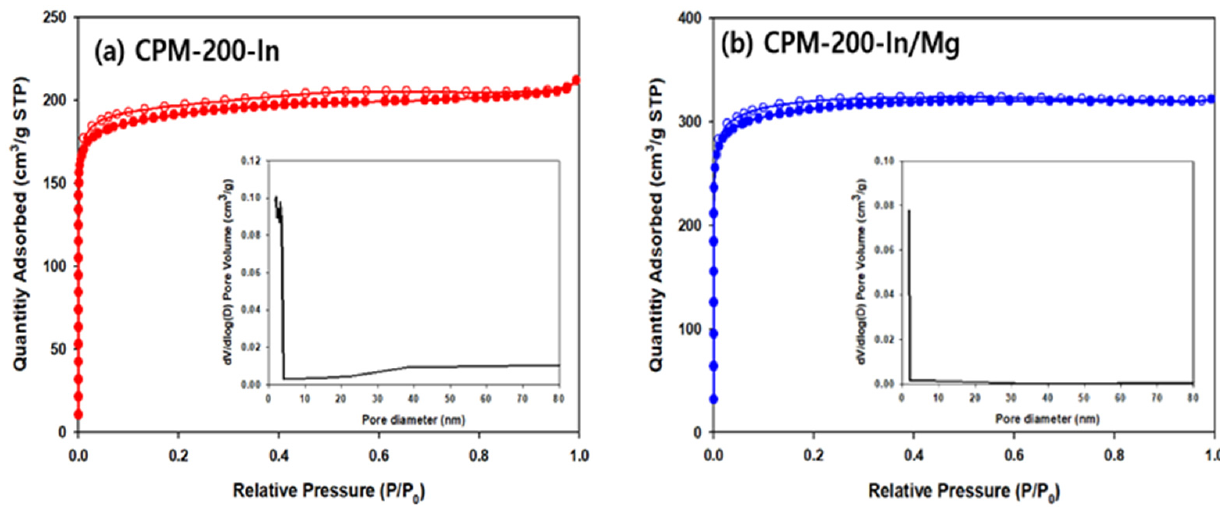
Figure 6. N 2 adsorption-desorption analysis of ( a ) CPM-200-In and ( b ) CPM-200-In/Mg.